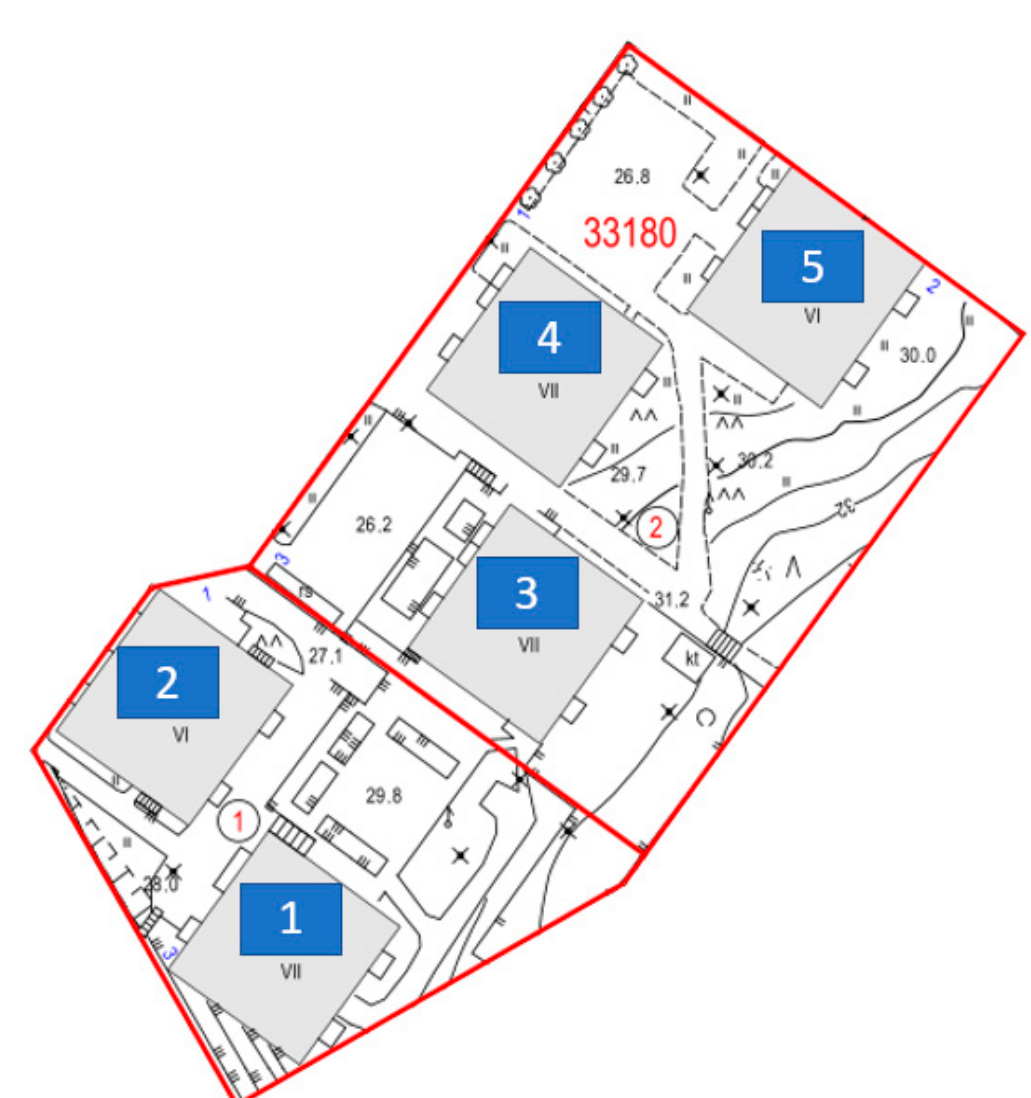
Figure 1. Layout of the studied case area. The case site included five apartment buildings that were refurbished in the order indicated by the blue boxes.